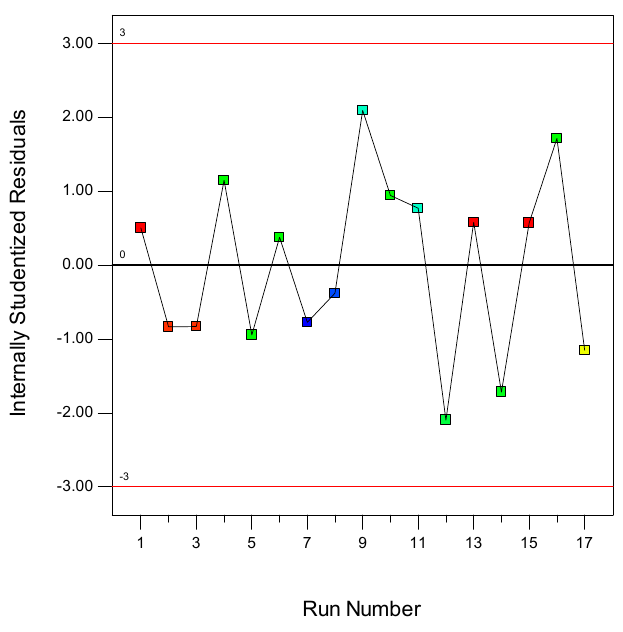
Figure 9 . Residual versus run order plot . Figure 9. Residual versus run order